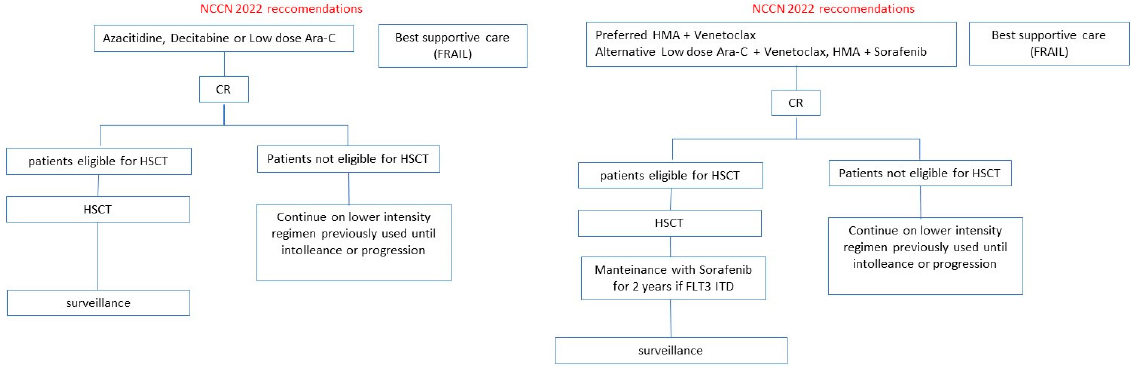
Figure 3. ELN and NCCN recommendations for FLT3mut AML patients unfit for intensive treat- ment.